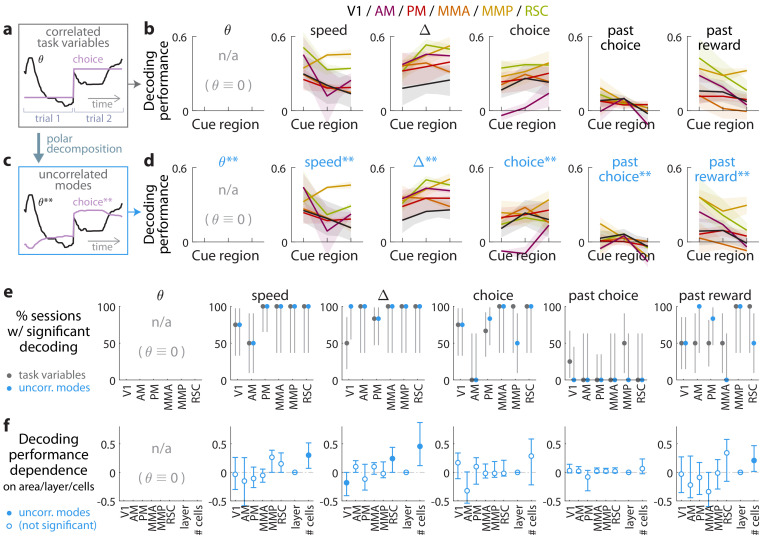
Qualitatively similar performances for decoding task variables from cue-locked response amplitudes in control experiments with view-angle restricted to zero in the cue region.(a–f) As in Figure 3, but using data from the θ-controlled experiments.